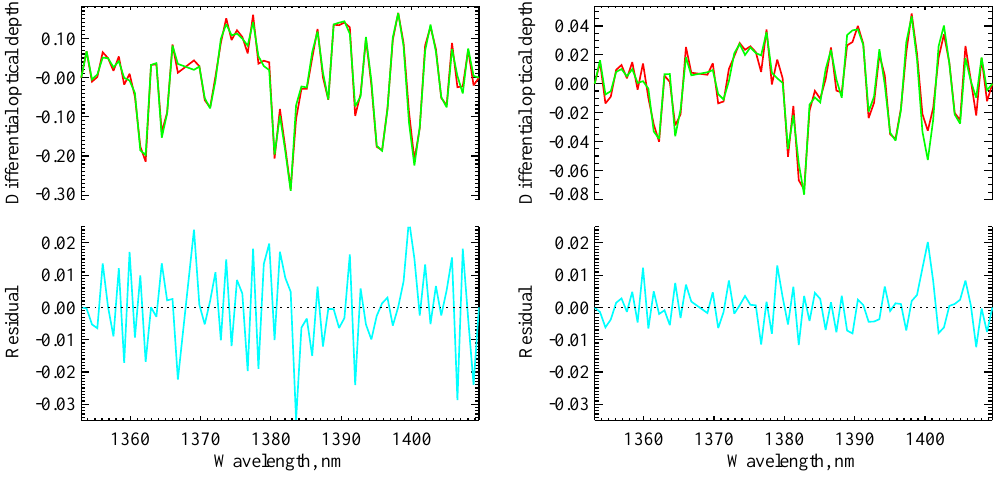
Fig. 2. Example spectral fits for tangent heights of 12km (left panels) and 21.9km (right panels). The upper panels show measured (red) and simulated (green) differential logarithmic spectra whereas the lower panels show fit residuals. The results are obtained for a SCIAMACHY limb measurement performed on 27 January 2004, at 17:18:22UTC (orbit 9986) over Boulder, CO, USA (40 ◦ N,105 ◦